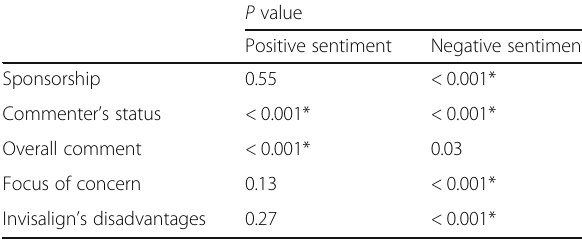
Table 5 P values of the Pearson ’ s chi-squared test for sponsorship, commenter ’ s status, and comment